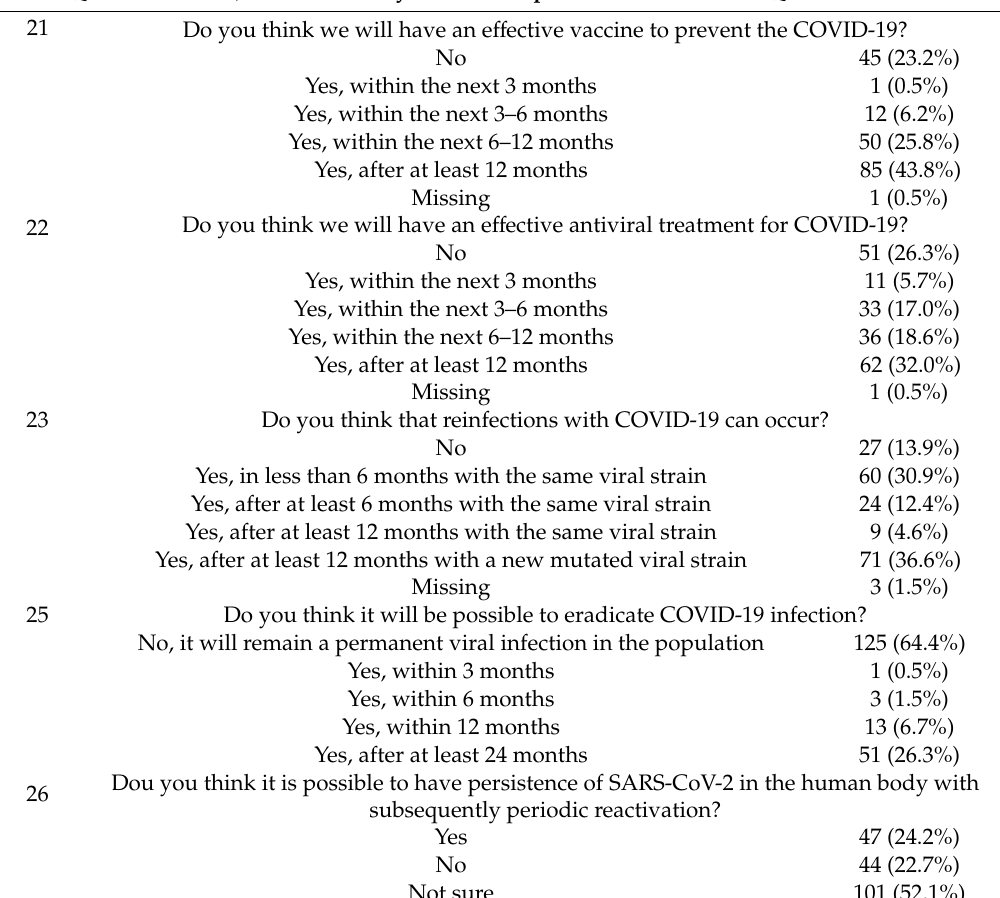
Table 4. Future developments regarding the COVID-19